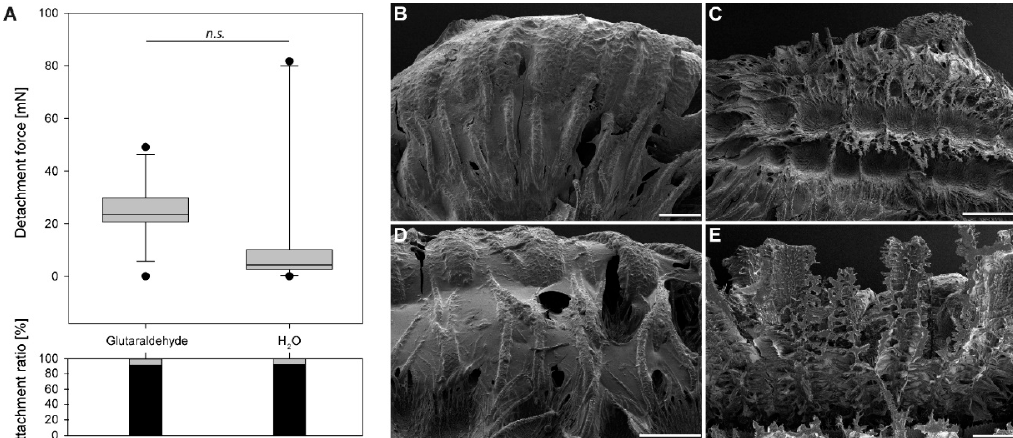
Figure 7. Detachment forces of glutaraldehyde treated eggs and subsequently water exposed eggs: ( A ) Boxplots of the detachment forces of both treatment cycles (above) and the corresponding attachment ratio (below). The horizontal line represents the median, the upper and lower borders of the boxes represent 25 and 75 percentiles and the whiskers represent 10 and 90 percentiles, n.s. = not significant (Wilcoxon Signed Rank Test, N 1,2 = 12, p = 0.23); ( B – E ) Scanning electron micrographs of the adhesive system of P. philippinicum eggs exposed to ( B ) glutaraldehyde, ( C , E ) toluol, ( D ) hexane. Scale bars: 500 μ m ( C ), 200 μ m ( B , D , E ).